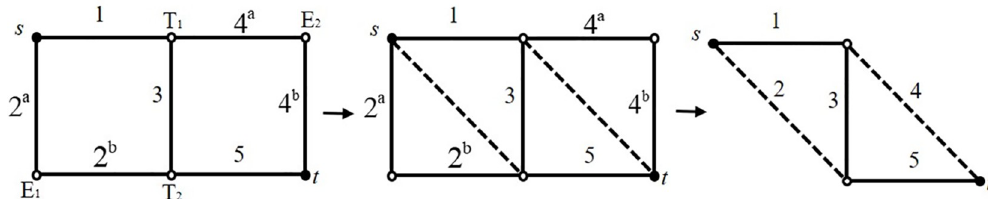
Fig 7. Bridge network diagram and simplified form of a pipeline